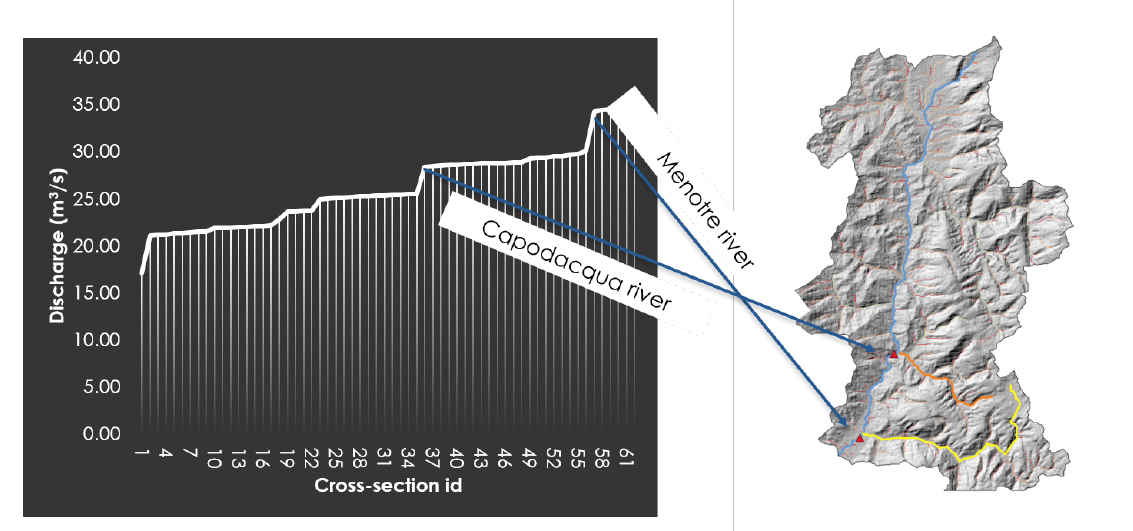
Figure 7. The line plot’s vertical axis is the discharge, and its horizontal axis is the upstream distance. The steps represent increases in discharge due to confluences. The arrows highlight the correspondence between the steps and the location in the map.